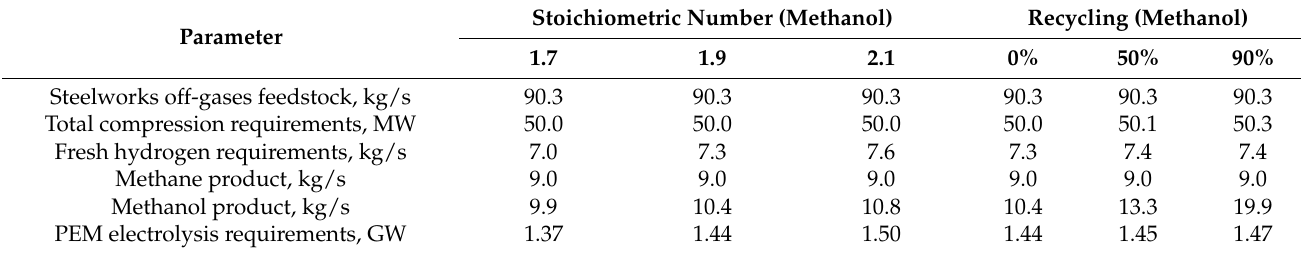
Table A7. Key results of the combined